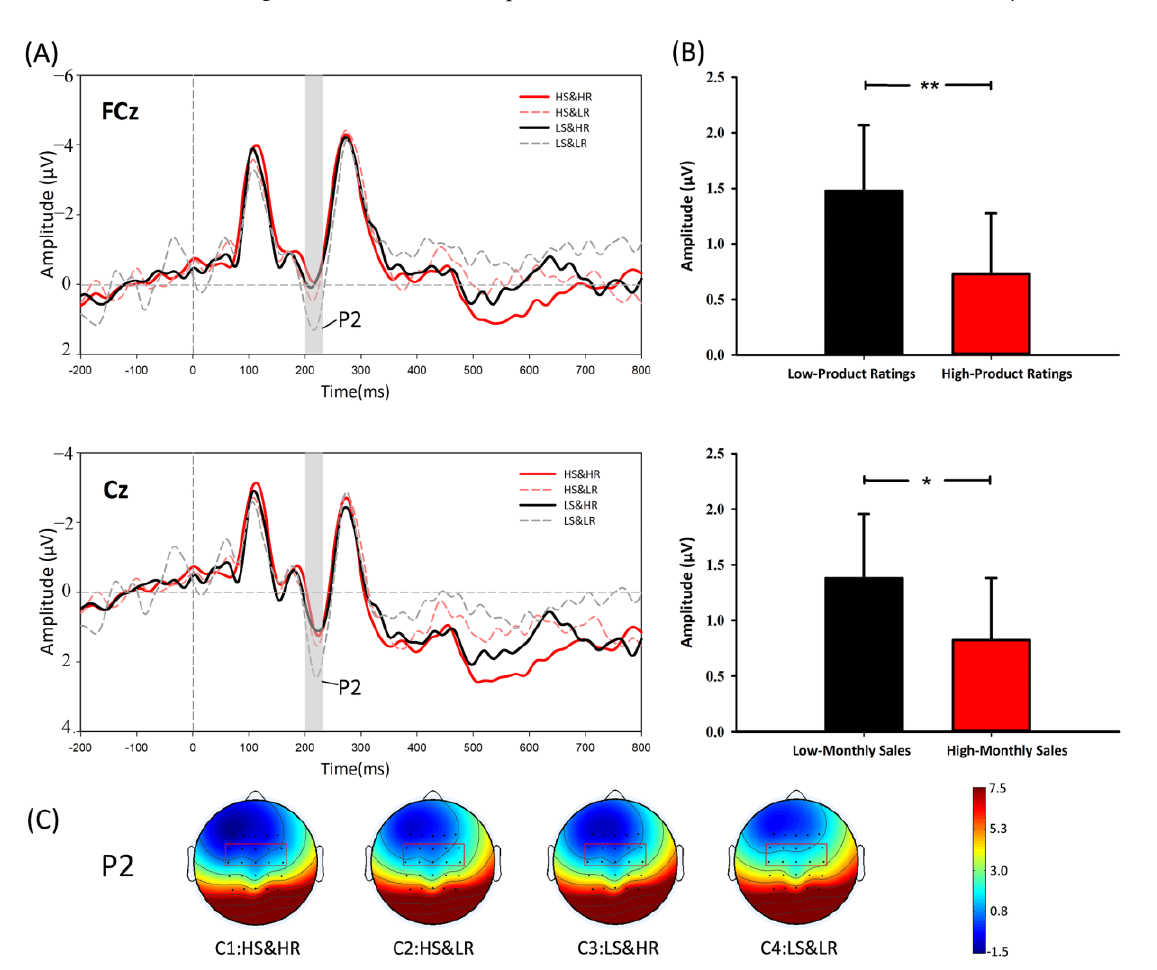
Figure 3. ( A ) Waveform diagrams of P2 component. ( B ) ANOVA results of P2. ( C ) Scalp topographic maps of P2 corresponding to four conditions. Note: * p < 0.05, ** p < 0.01.